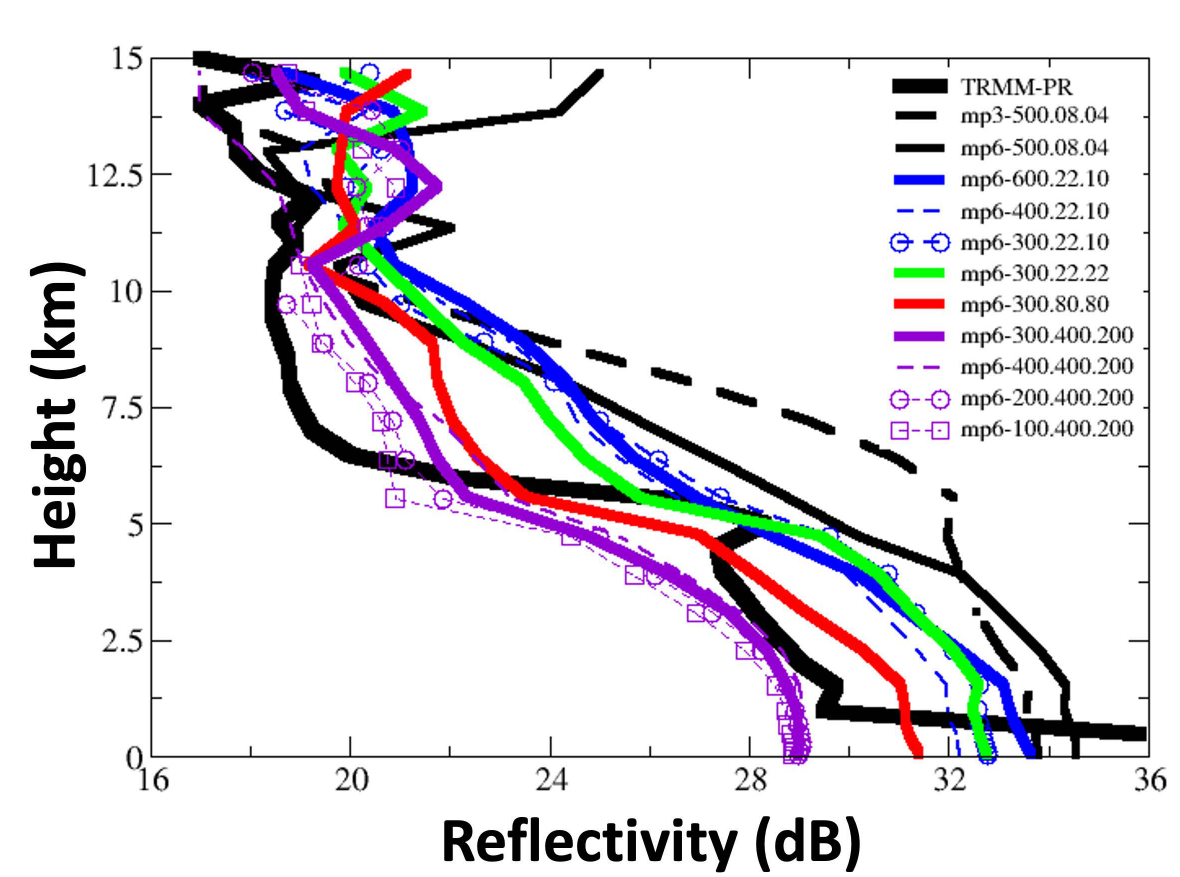
Figure 12. Comparing the Mode of the CFAD distributions between observed and simulated profiles of maximum attenuated radar